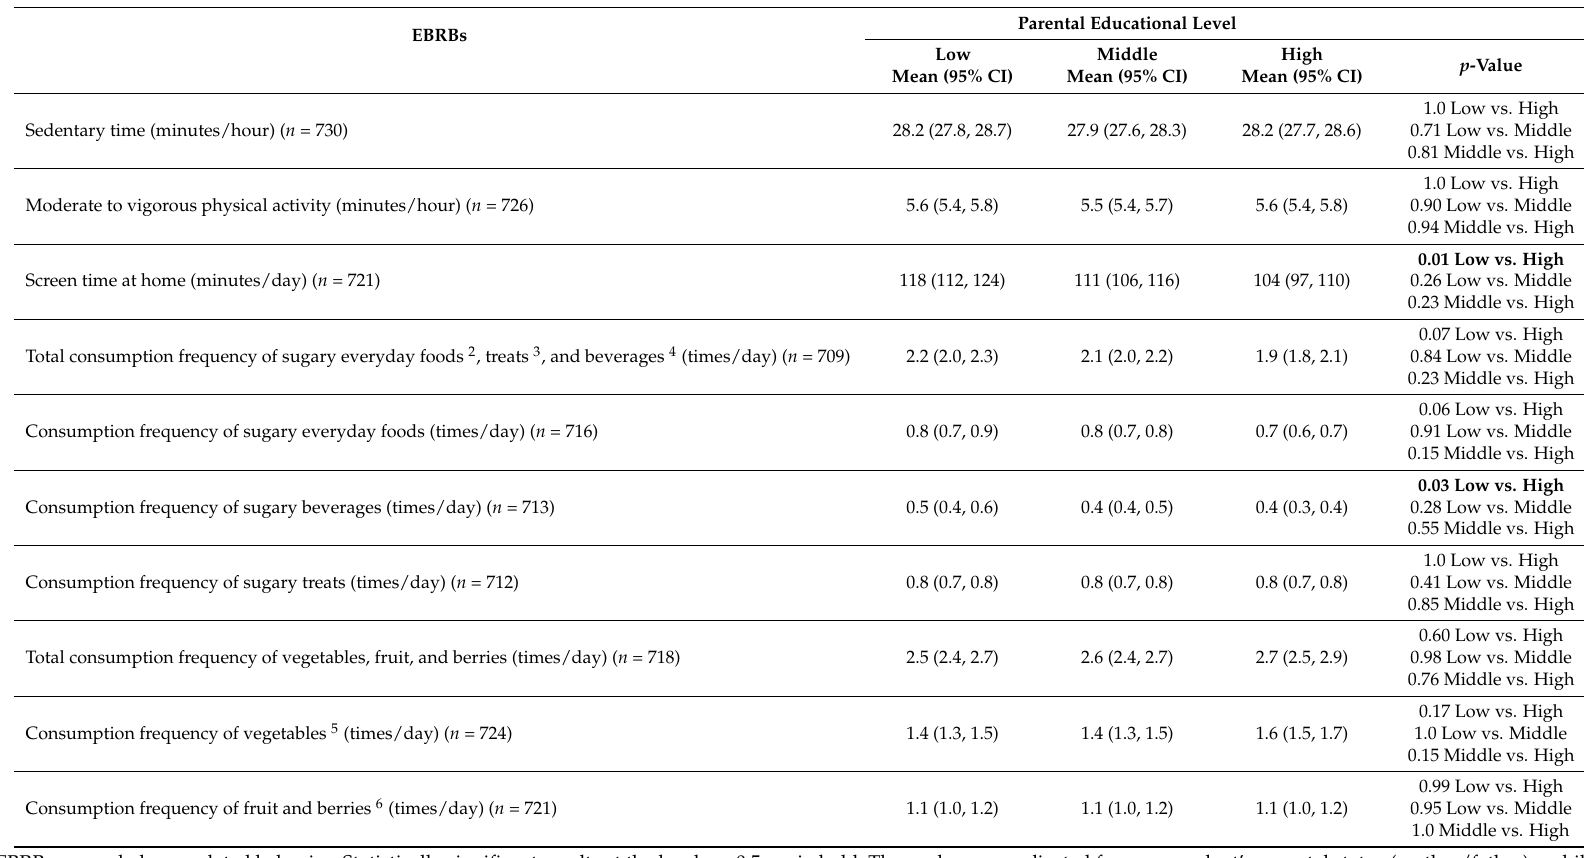
Table 2. Adjusted means and 95% confidence intervals (95% CI) 1 for EBRBs according to parental educational level (low/middle/high) from Ancovas (LSD, with Sidak